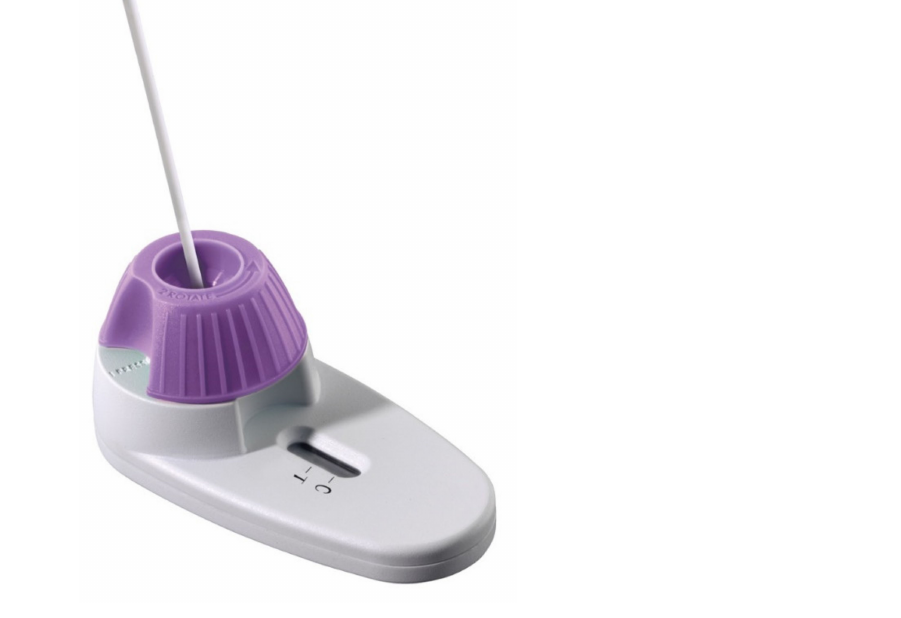
Figure 1. SavvyCheck ™ Vaginal Yeast Test kit (picture used with permission of the